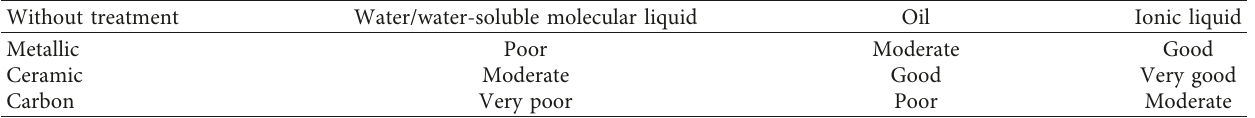
Table 3: Stability of nanoparticles in different